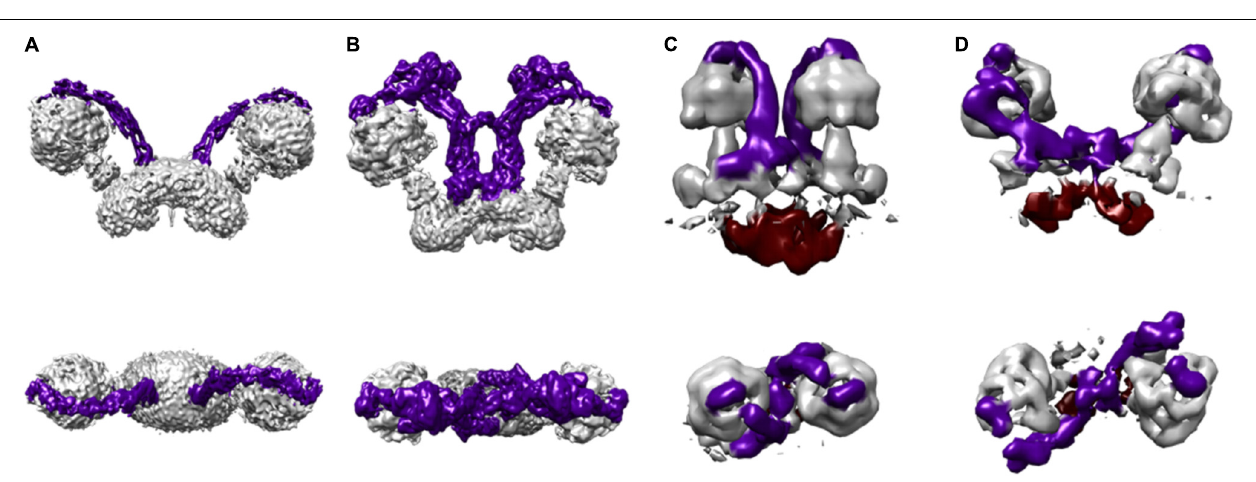
FIGURE 4 | Protozoan and metazoan type dimers. Three dimensional maps of dimeric ATP synthases from (A) Saccharomyces cerevisiae (EMD 7067) (Guo et al., 2017) representing a metazoan-type dimer, (B) Polytomella sp. (EMD 2852) (Allegretti et al., 2015), (C) Paramecium tetraurelia (EMD 3441) (Mühleip et al., 2016), and (D) Euglena gracilis (EMD 3559) (Mühleip et al., 2017) representing the protozoan-type dimers. The colors in the schematizations represent: peripheral stalks in dark purple and the inter membrane space density below the c -ring in deep red (C,D)